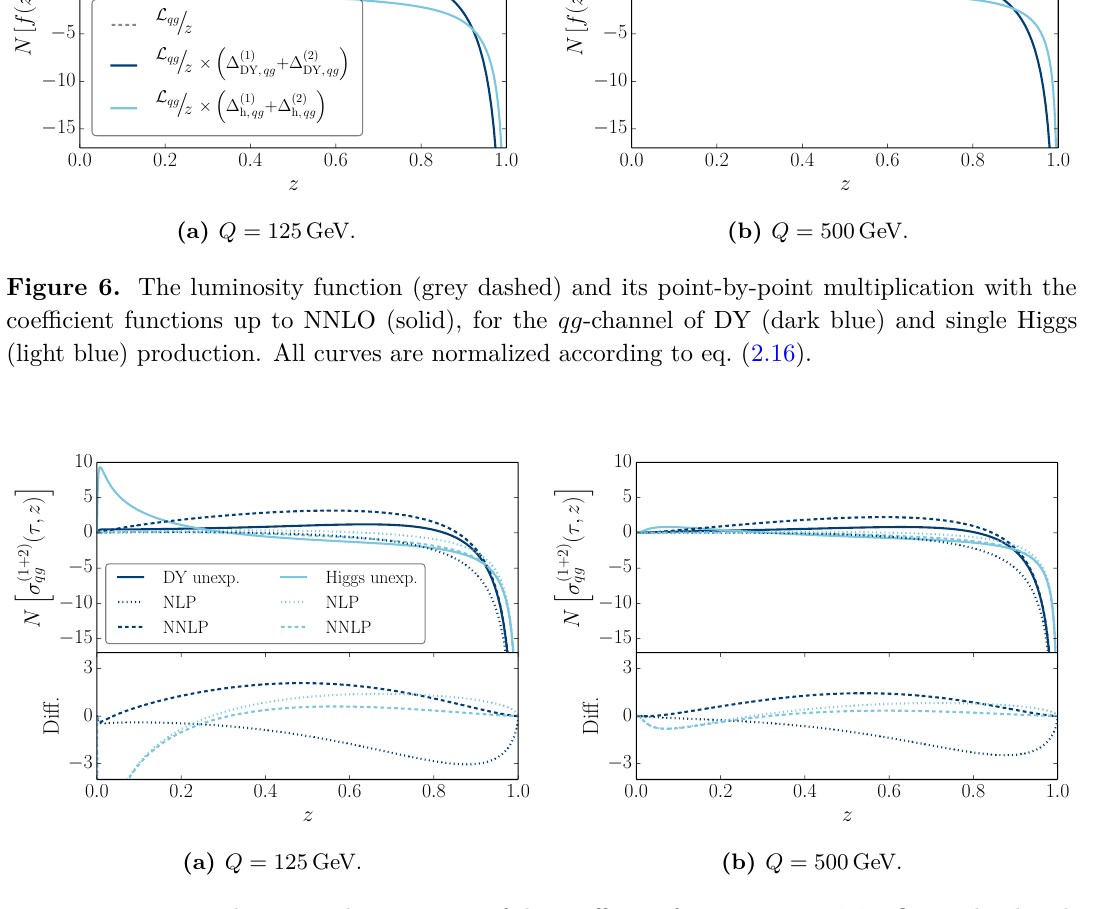
Figure 7. Exact and truncated expressions of the coefficient functions up to NNLO, weighted with the parton luminosity, for the qg -channel of DY and single Higgs production. Labeling is the same as for figure 5. All curves are normalized according to eq.